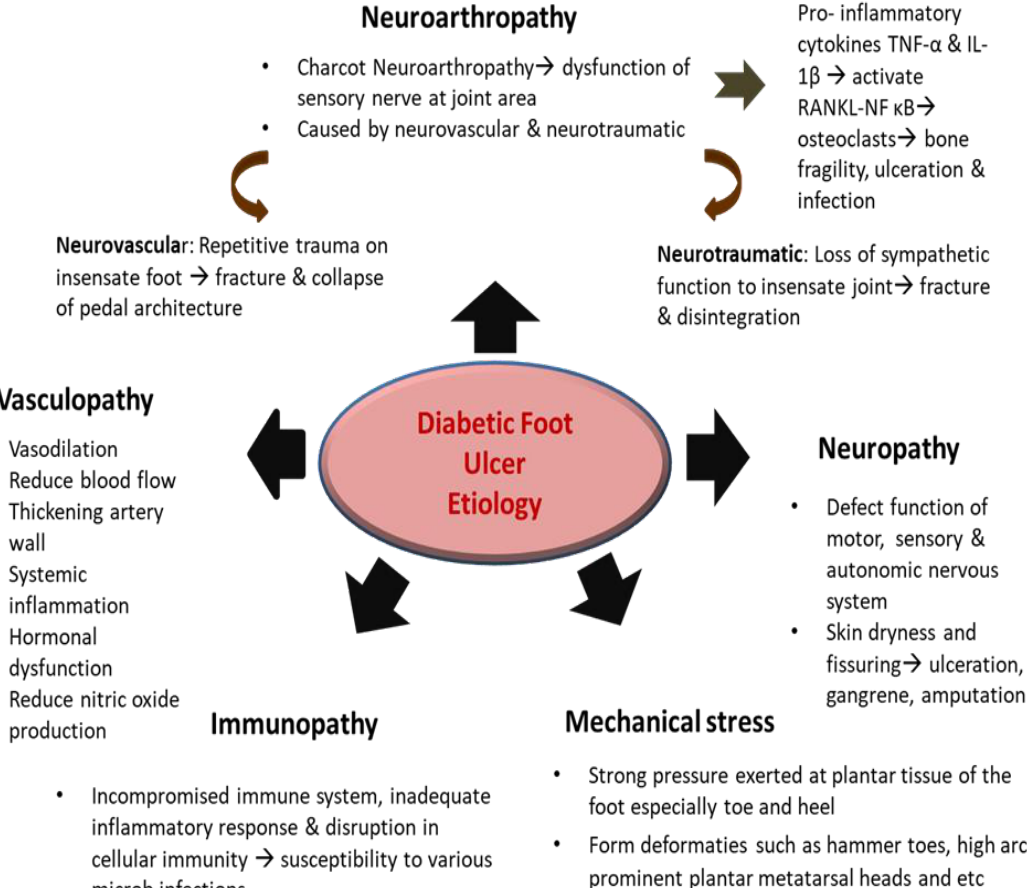
Figure 3. The pathophysiology of diabetic foot ulcer